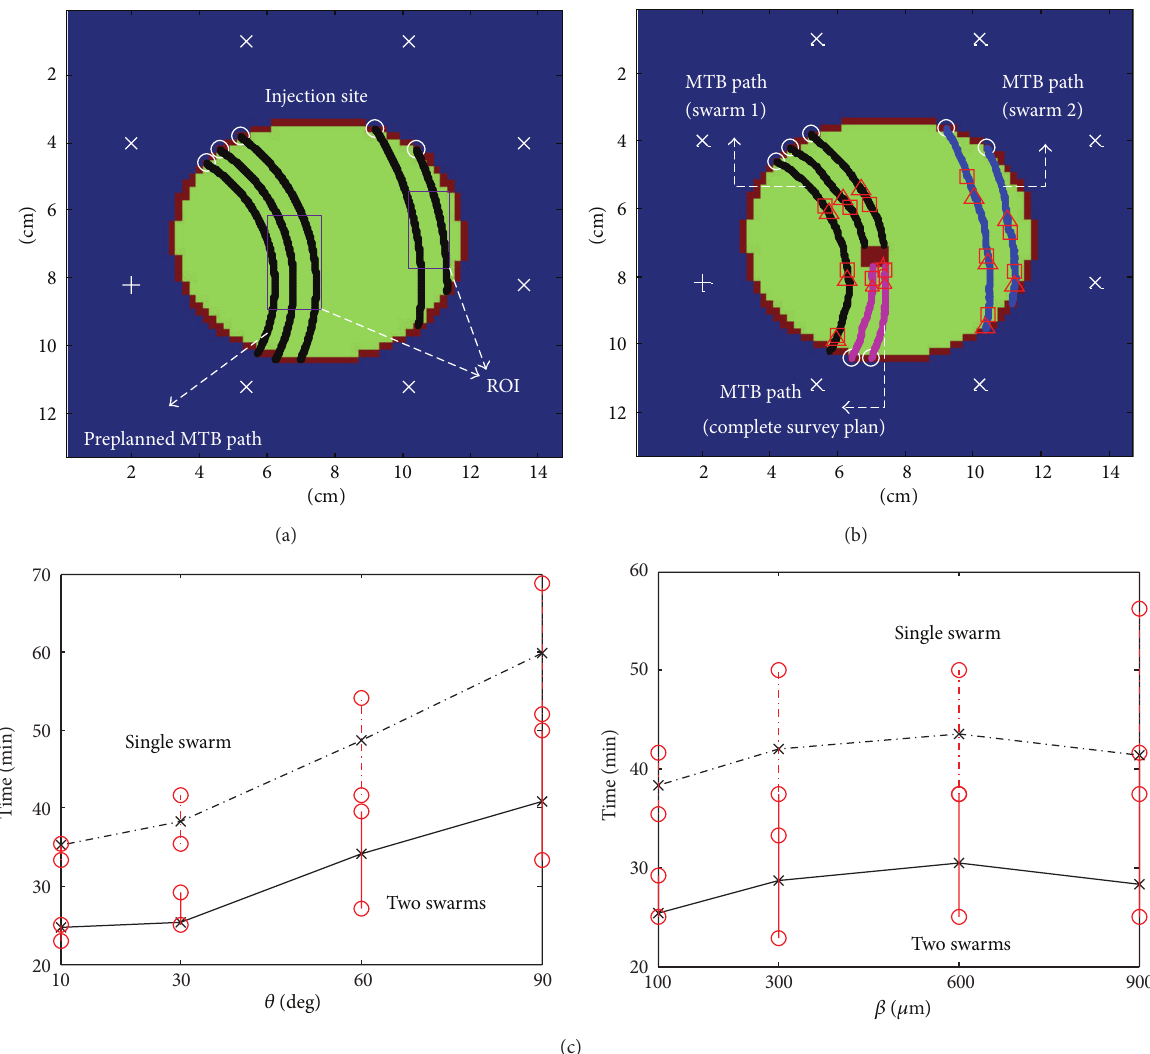
Figure 6: (a) Preplanned MTB paths for the system setup in Figure 3(b). (b) Simulated DMI footprints. The MTB injection sites are marked with “ ∘ .” The actual and estimated positions of the MTB during the tracking phase are marked with “ 󳵻 ” and “ ◻ ,” respectively. The estimated final destination of contrast agent (i.e., DMI footprint “sink”) is marked with “ 󳀅 .” (c) Sensing time versus angular spread 𝜃 and mean step size 𝛽 of the directional random walk for single- and two-swarm administration. The fixed parameter values are 𝛽 = 100 𝜇 m in the former and 𝜃 = 30 ∘ in the latter. The markers “ × ” and “ ∘ ” correspond to the sensing time mean and dispersion,